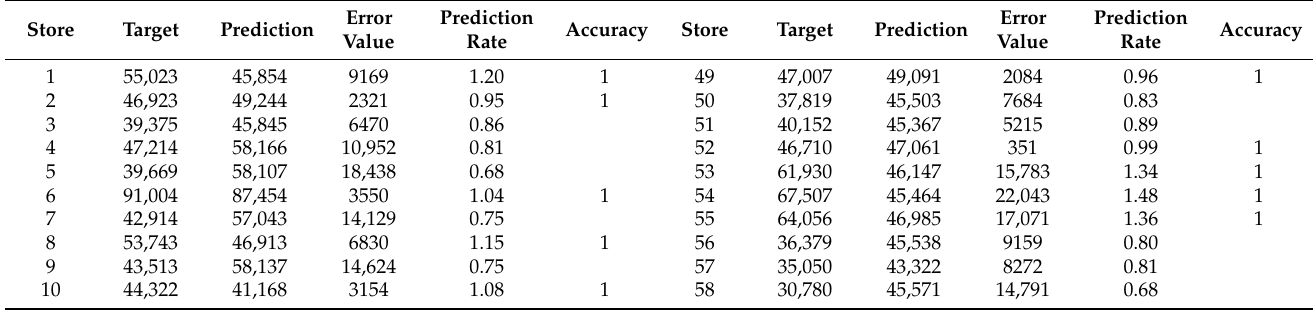
Figure 3. Mean squared error. (Note: le9 = 1 × 10 9 ). Table 12. Actual deduction